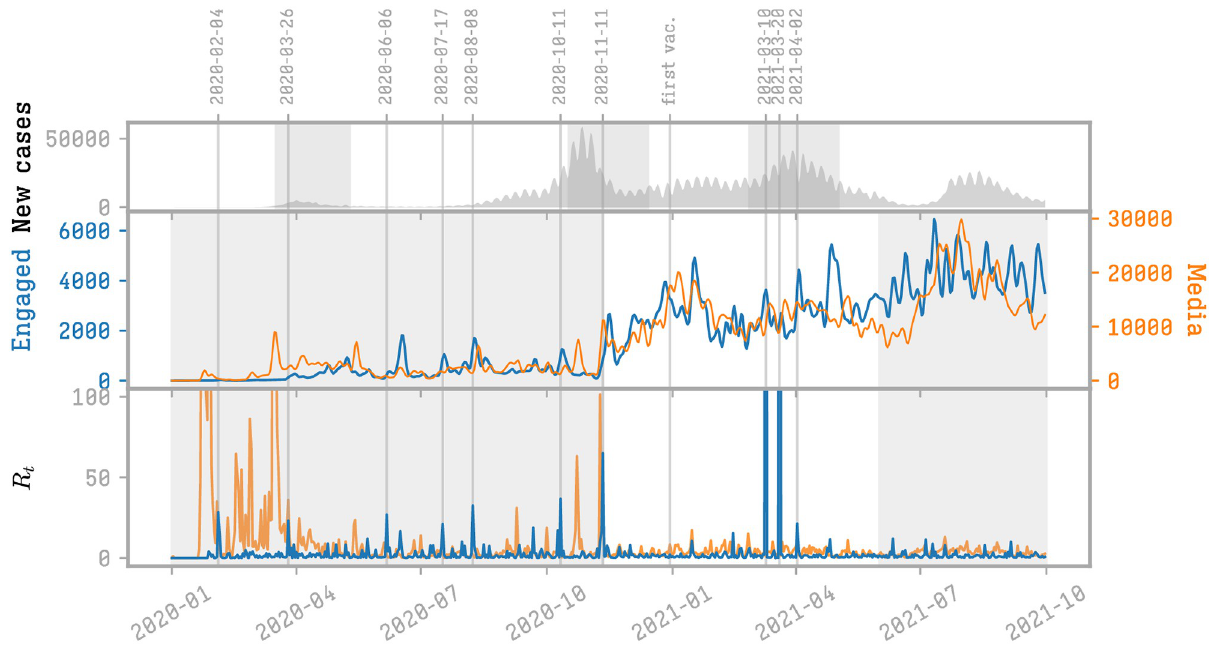
Fig 3. Engagement of users with vaccine-critical content. Above: evolution of the total number of users engaging with news media (orange) or with vaccine-critical contents (blue). Below: the reproduction number shows peaks of engagement around some events. The greyed area on the top panel is proportional to the daily new cases in